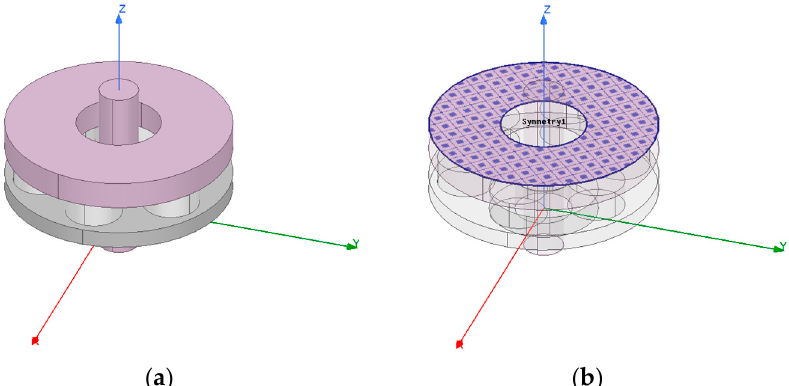
Figure 9. Finite element simulation model of the electromagnetic damper: ( a ) Simplified model; ( b ) Central cross section of the stator disk.